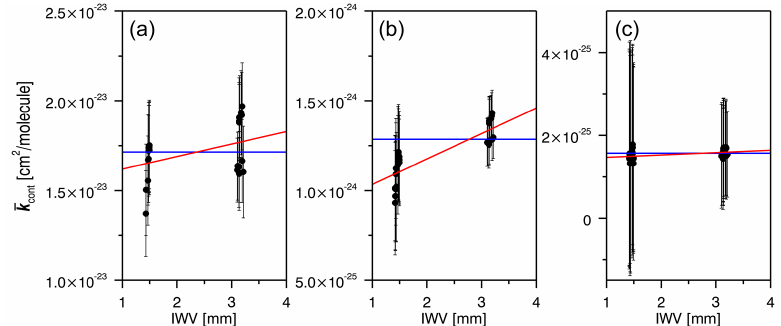
Figure B2. Examples of the scaling of the mean continuum absorption coefficient ¯ k cont (black data points) with respect to IWV (a) within a water vapor absorption band (4100cm − 1 ) , (b) in the wings of an absorption band (4700cm − 1 ) , and (c) in a window region (2700cm − 1 ) . The blue line corresponds to the best-fit constant scaling, the red line to the best-fit linear